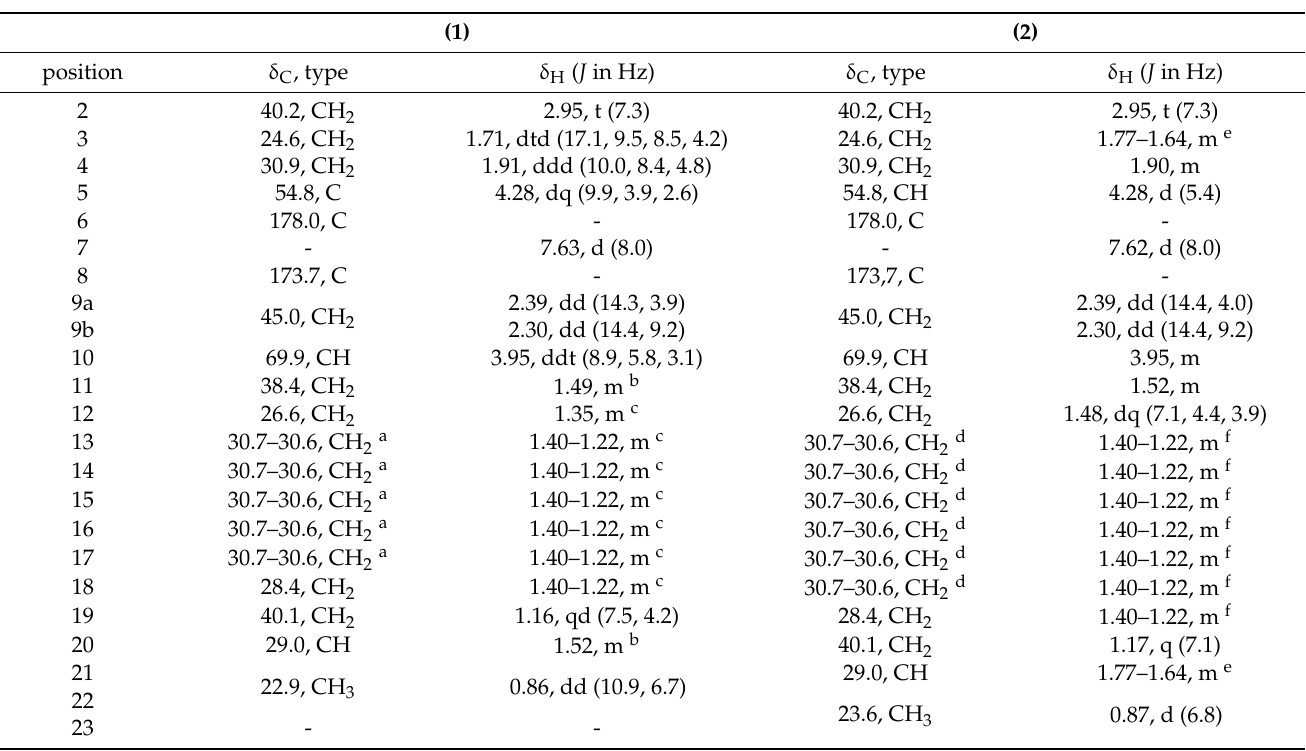
Figure 3. Structures of lyso-ornithine lipids isolated from Lacinutrix sp. ( 1 ): C 20 H 40 N 2 O 4 , ( 2 ): C 21 H 42 N 2 O 4 . Table 1. 1 H and 13 C assignments for 1 and 2 .